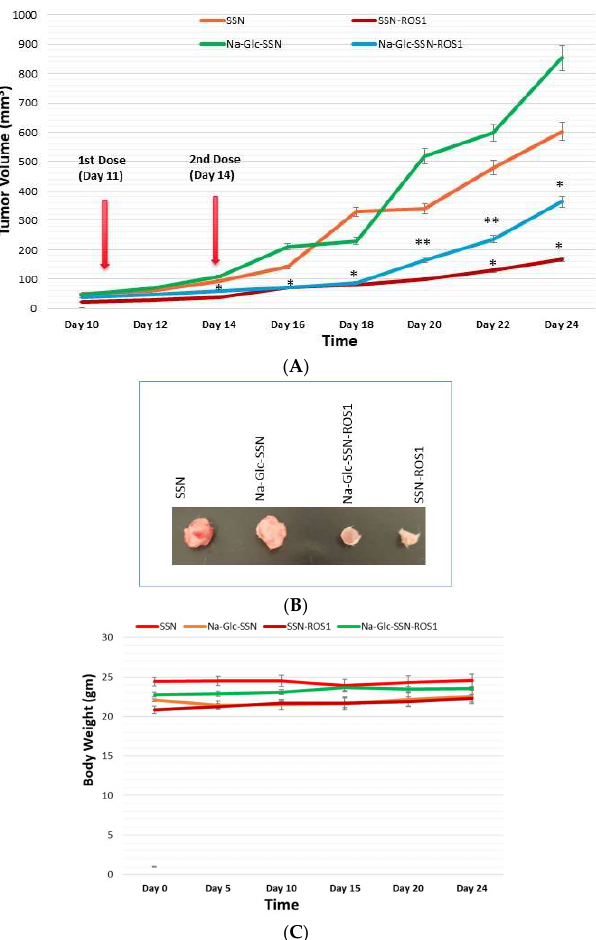
Figure 17. Effects of intravenously administered nanoparticles and siRNA-loaded nanoparticles on tumor regression. ( A ), Images of excised tumors at day 20 ( B ) and total body weight ( C ) in a 4T1 tumor bearing mice. 4T1 cells were inoculated subcutaneously on the mammary pad of mice. Tumor-bearing mice were treated intravenously through tail vein injection with 50 µ L of either nanoparticles or siRNA-loaded nanoparticles, formed by the addition of 60 mM SrCl 2 , 300 mM of NaCl, and 200 mm of D -glucose to 10 mM of Na 2 SO 3 in the absence and presence of 50 nM of ROS1 siRNA, respectively, when the tumor volume reached approximately 39 mm 3 . Four mice per group were used and data were represented as mean ± SEM of tumor volume. Values were very significant (**) at p value 0.001 to 0.01 and significant (*) at p value 0.01 to 0.05 as compared to the control